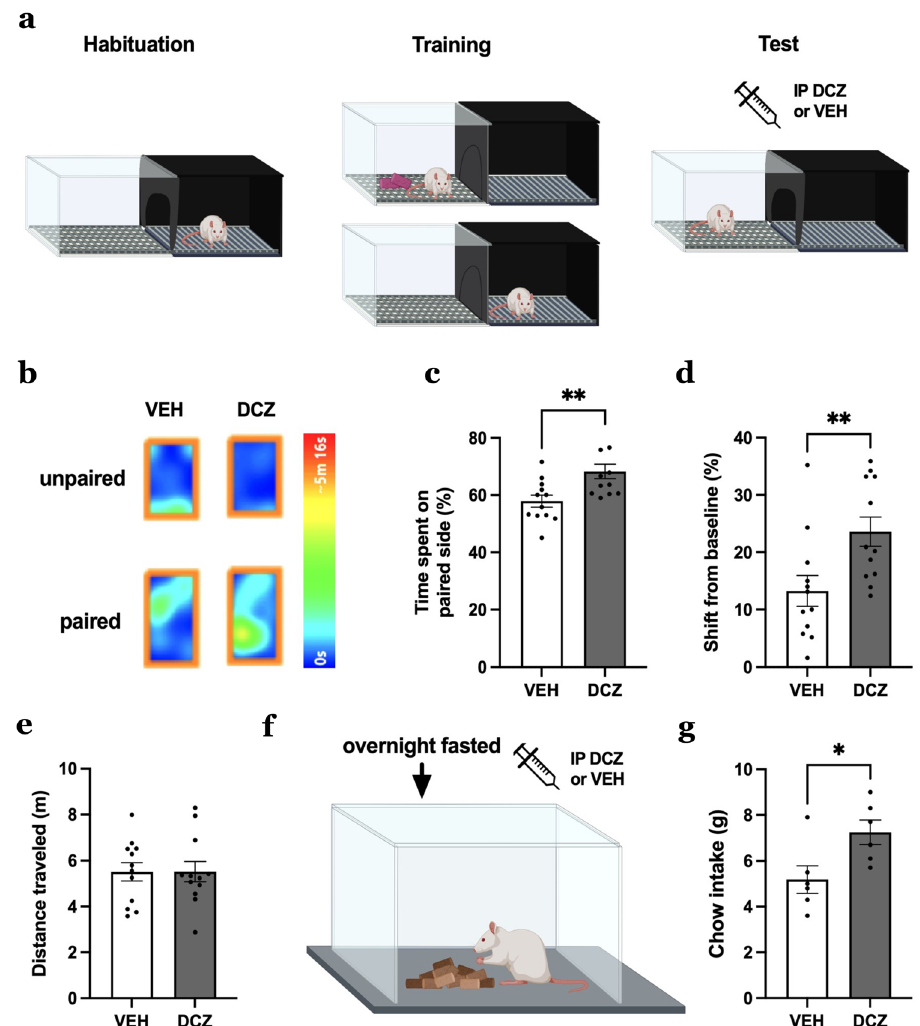
Fig. 5 | MCH neuron activation increases appetitive responses to contextual- based food-predictive cues and meal size after an overnight fast. a Schematic diagram of chemogenetic activation of MCH neurons during CPP in rats ( n =12). b Representative heat maps (single animal) depicting the time spent on the food- paired or unpaired side between vehicle and DCZ treatments. c – e Effects of che- mogenetic activation of MCH neurons during CPP test phase (data analyzed using Student ’ s two-tailed paired t -test, n =12 rats) with c percentage time spent on the food-paired side,** P =0.0028 and d shift from baseline (difference in percentage